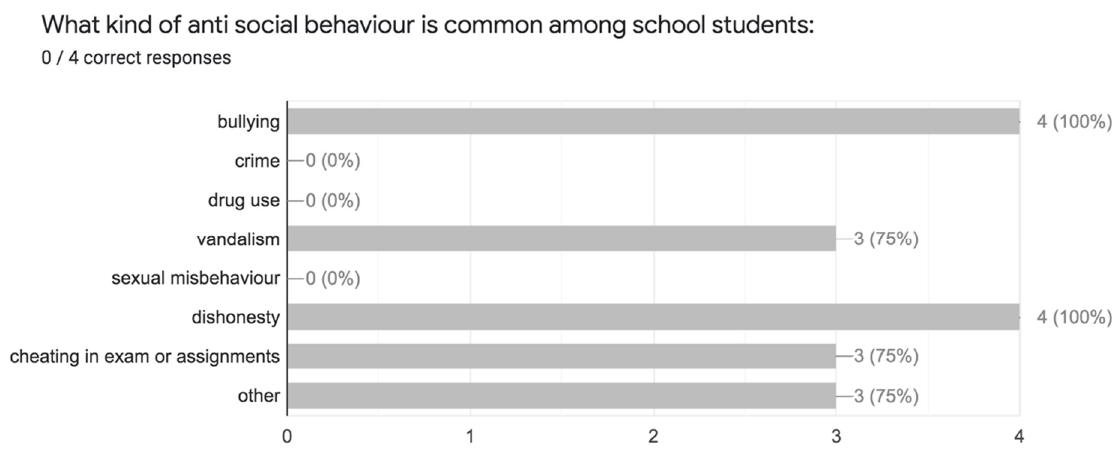
Figure 2. Common antisocial Issues among students in Shah Alam.